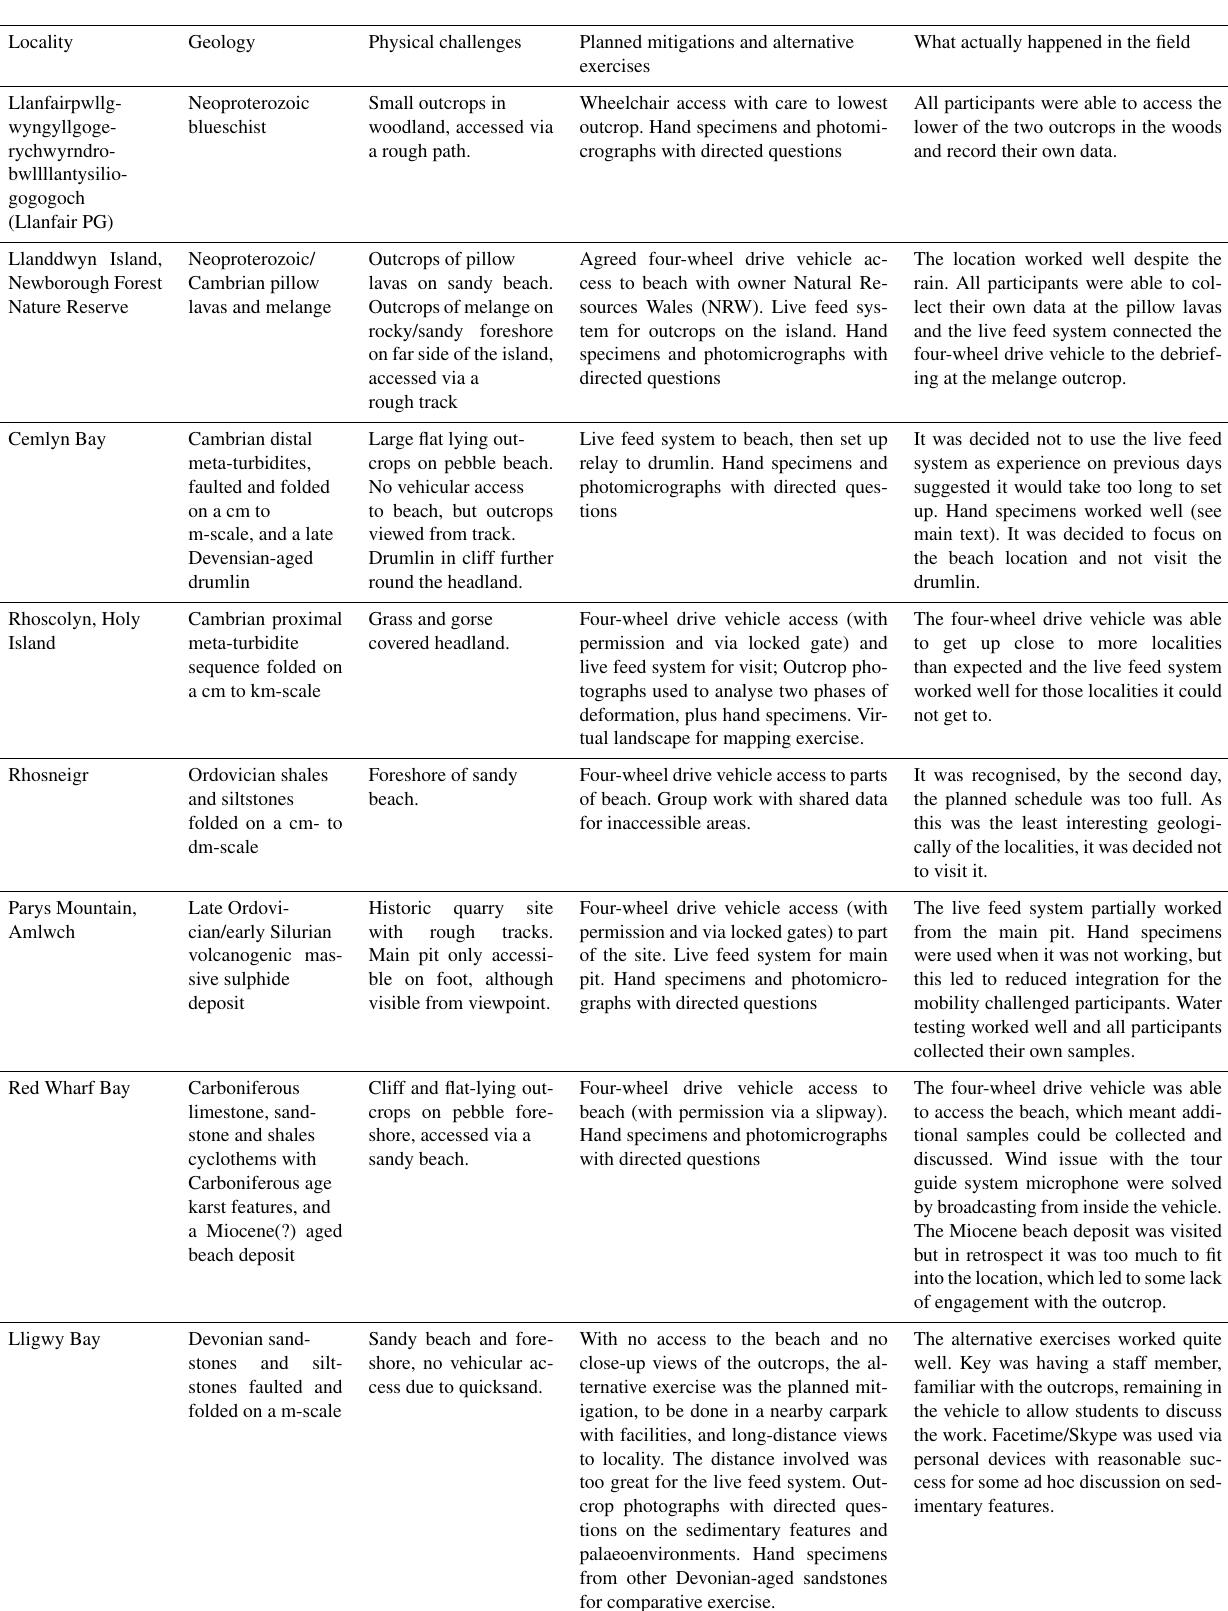
Table 1. Details of the localities visited. The localities are listed in geological age from oldest to youngest.